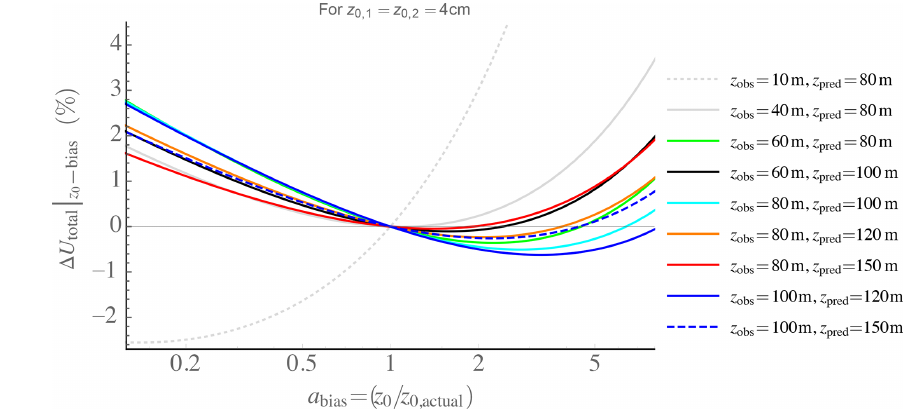
Figure A2. Total uncertainty vs. bias in background roughnesses z 0 , 1 and z 0 , 2 due to different combinations of measurement and prediction heights for the case of grassland ( z 0 = 4cm) at both measurement and prediction sites.